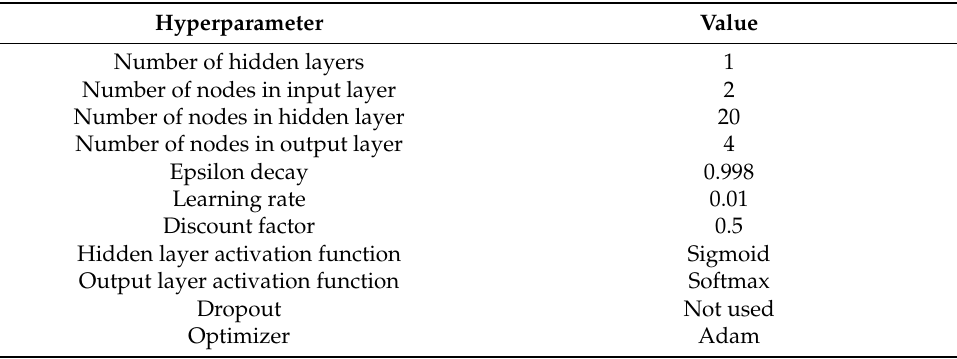
Table 4. Hyperparameters of the neural